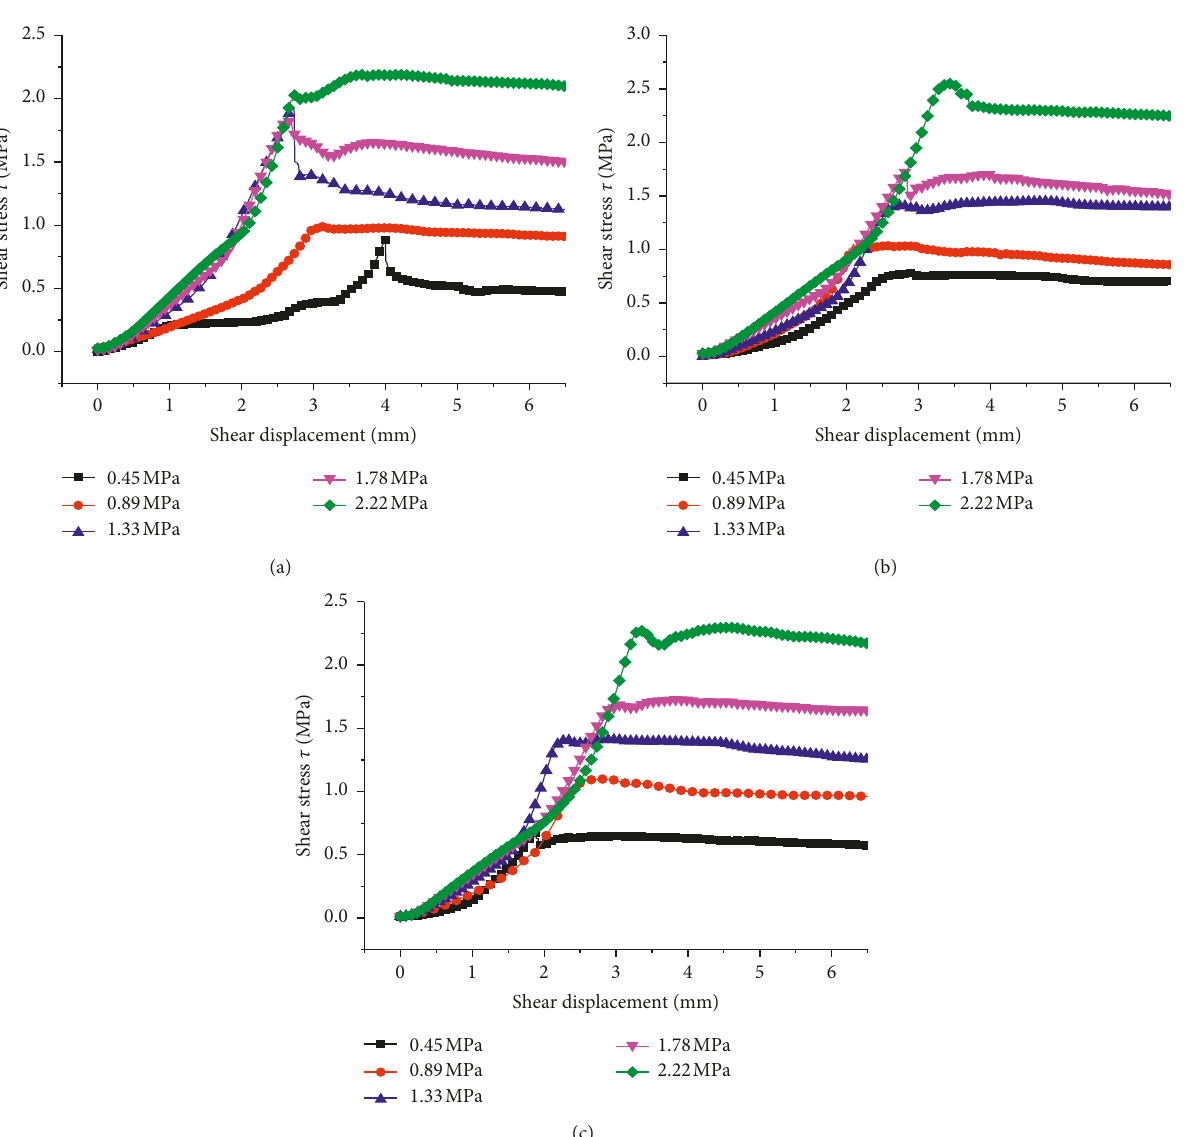
Figure 6: Shear stress-shear displacement curves of the grouted joint with one bolt (a), two bolts (b), and three bolts (c) of 45 °